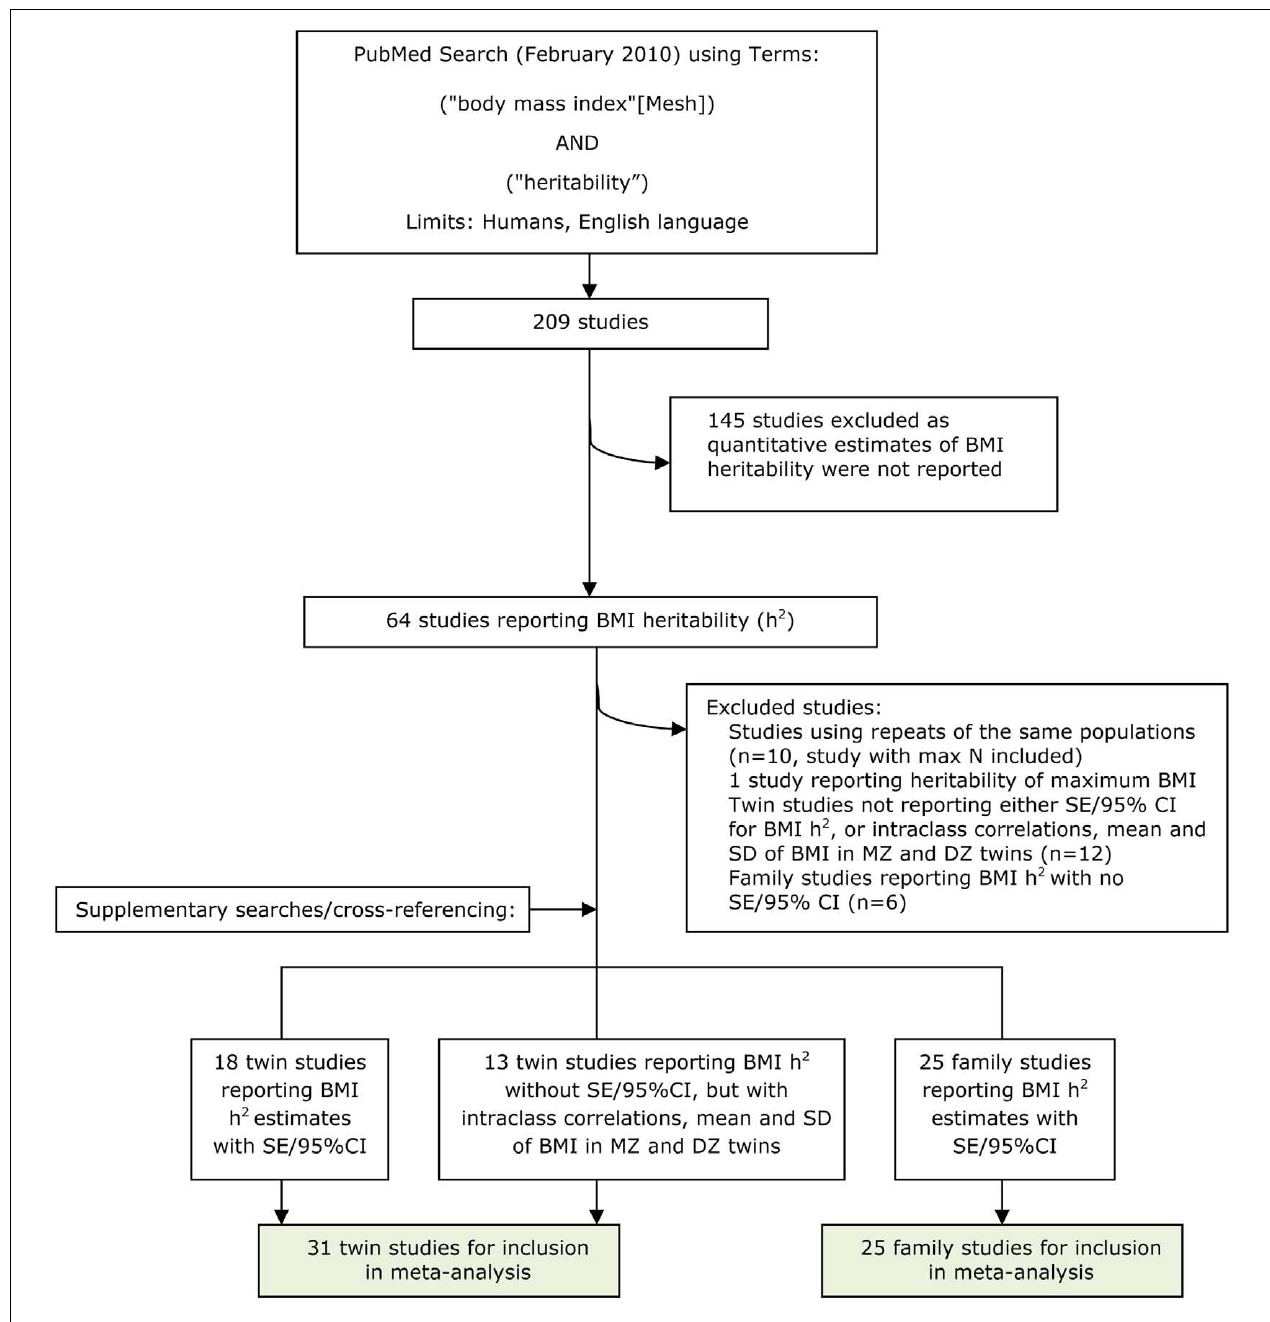
FIGUREA2 | Flow chart of identification of relevant literature.